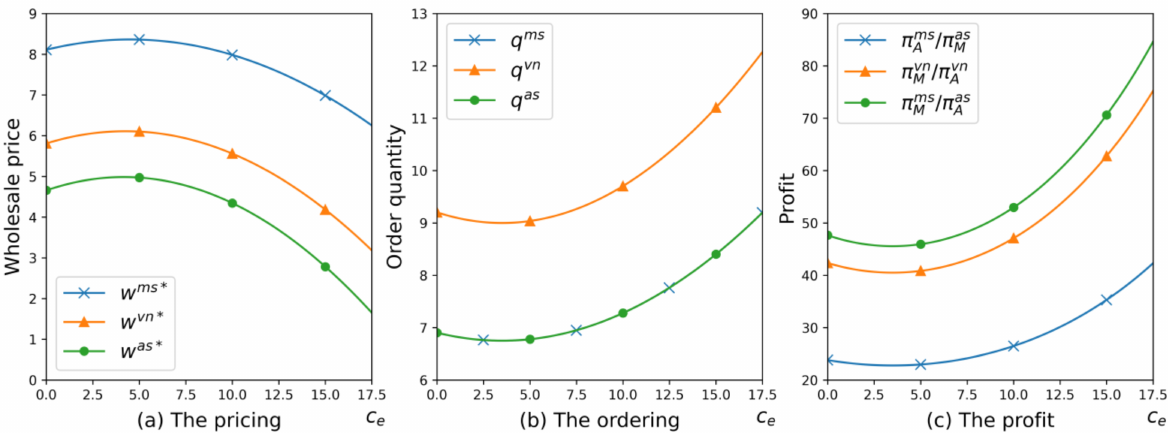
Figure 1. Impact of carbon trading price in different power structures: ( a ) impact of carbon trading price on the pricing; ( b ) impact of carbon trading price on the ordering; ( c ) impact of carbon trading price on the